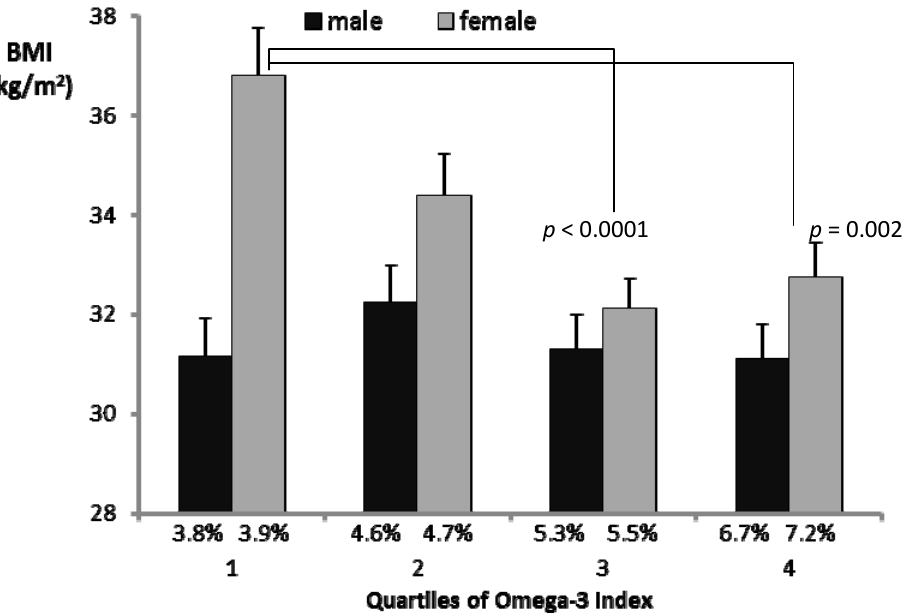
Figure 1. Average BMI values in quartiles of the Omega-3